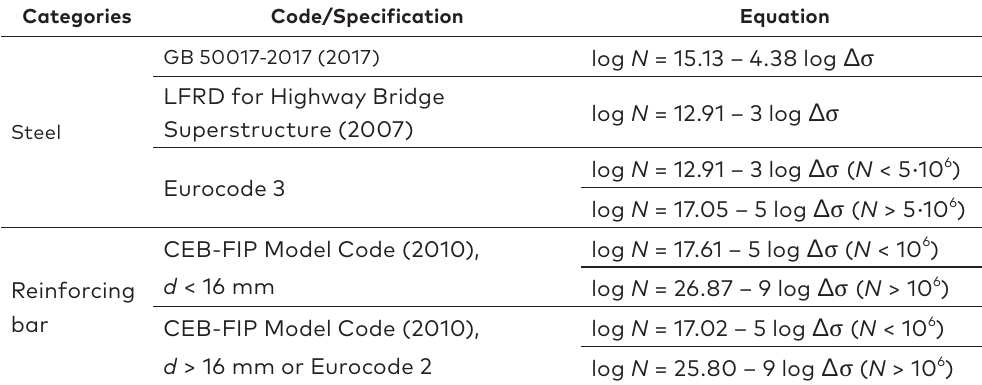
Table 3. S - N curves in the current codes and